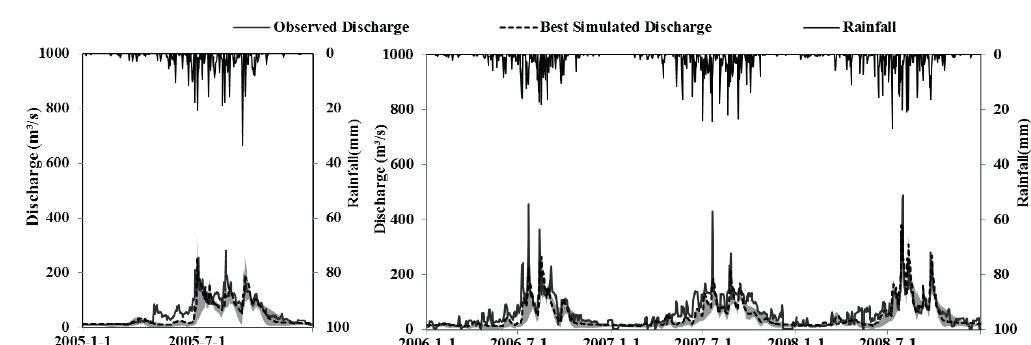
Fig. 5 Rainfall, observed and simulated discharge and 95PPU (shaded area) for calibration using river discharge data of year 2005 and validation period